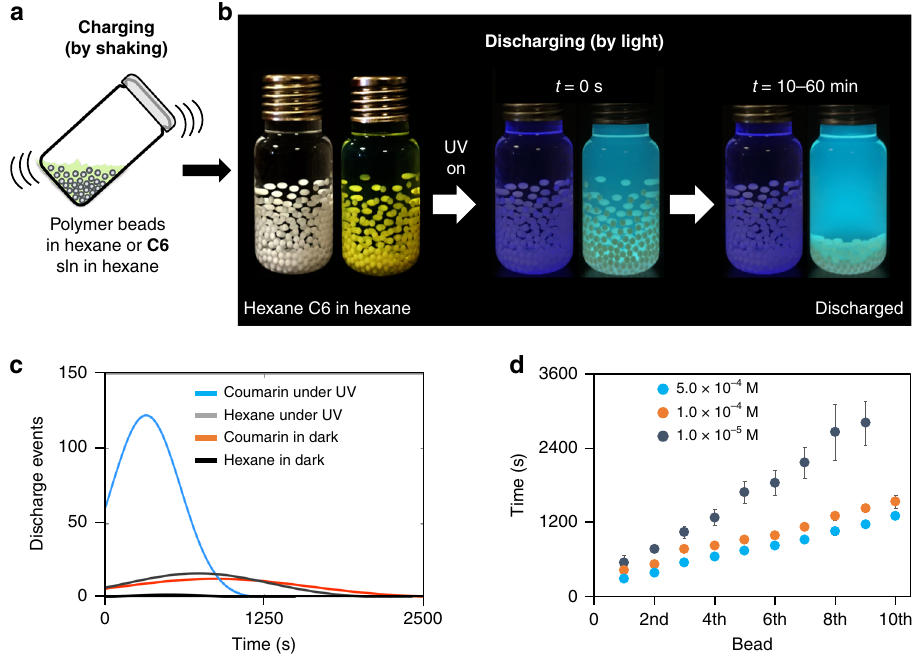
Fig. 2 Light controlled discharging of tribocharged polymer beads. a Poly(tetra fl uoroethylene) (PTFE) beads in hexane or in a coumarin 6 (C6) solution (5 × 10 − 4 M, dry hexane) are tribocharged by shaking on a vortexer for 1 min. (In the photo, 120 beads/vial were used for better visualization of the event, in a typical experiment only 40 beads/vial were used). b The charged beads “ stick ” electrostatically to the walls of the vials and stay stuck on the walls for hours to days. When the vials are illuminated with a UV lamp, only the beads in C6 solution discharge (within a few minutes) and fall to the bottom of the vial. The charge/discharge events can be repeated for hundreds of cycles without any signi fi cant change in the results, the data compiled after six individual runs with 40 beads each is shown in c . Data from fi ve independent experiments was collected (a total of 200 beads for each experiment, from which only the beads displaying a “ discharge event ” were counted); curve fi t on data collected in experiments was made by Matlab 2017 program using distribution function. For experimental details see Methods and Supplementary Movies 1 and 2. d Discharging times of fi rst 10 beads in the experiments in b . Error bars correspond to standard deviations determined from six independent experiments. Source data are provided as a Source Data fi